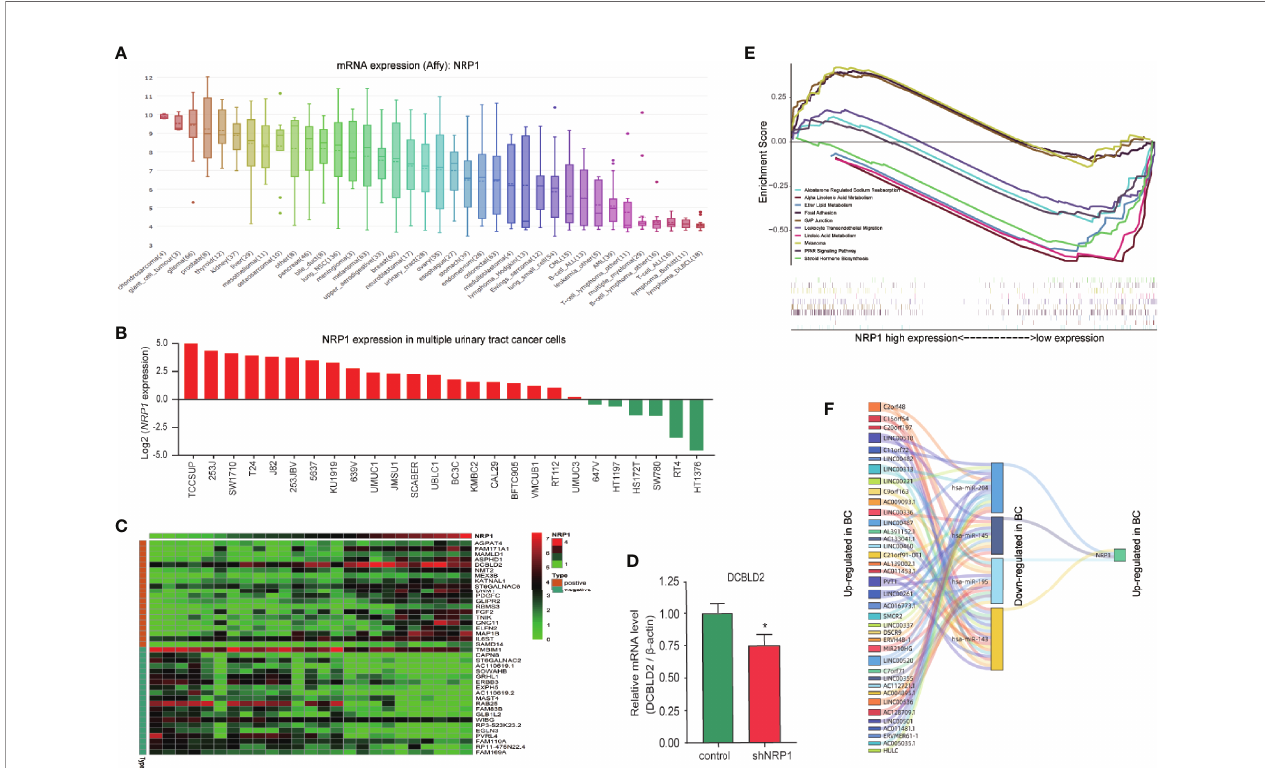
FIGURE 8 | Co-expressed genes analysis and ceRNA network prediction. (A) NRP1 mRNA expression in various cancer cell lines obtained from CCLE database. The abscissa is the tumor type and sample size, and the ordinate is the expression of target genes. (B) NRP1 mRNA expression in 26 urinary tract cancer cells extracted from CCLE database. We took the logarithm of the original data for better visualization. (C) Heatmap of the top 20 co-expressed genes with NRP1 in urinary tract cancer cells in both upregulated and downregulated groups. (D) the mRNA expression of DCBLD2 in 5637 cells with NRP1 silencing were measured using qRT-PCR. * p < 0.05 vs . the control group. (E) The signi fi cantly enriched signal transduction pathways of co-expressed genes of NRP1 in urinary tract cancer cells obtained using GSEA analysis. (F) A ceRNA sankey diagram of NRP1 constructed using the data extracted from TCGA